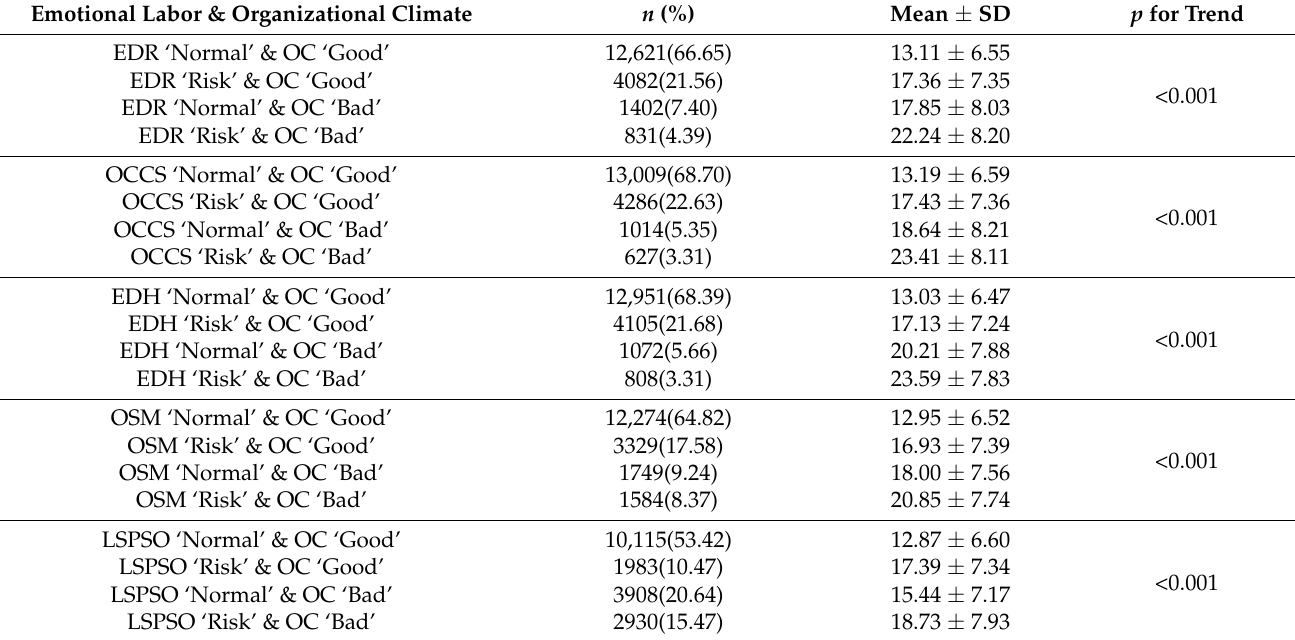
Table 3. Mean values and standard deviations (SD) of burnout according to the four groups of the combinations of emotional labor with organizational